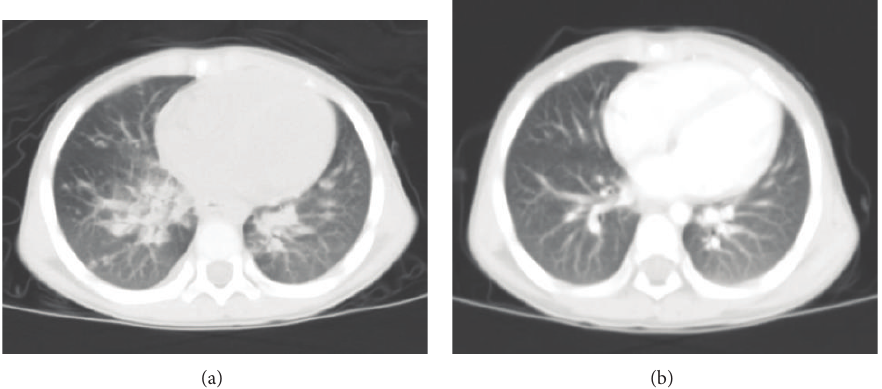
Figure 3: Thoracic CT reveals reticulonodular shadows in the lung window (a); after five weeks of treatment, thoracic CT showed that the lesions of the lung were reduced (b).